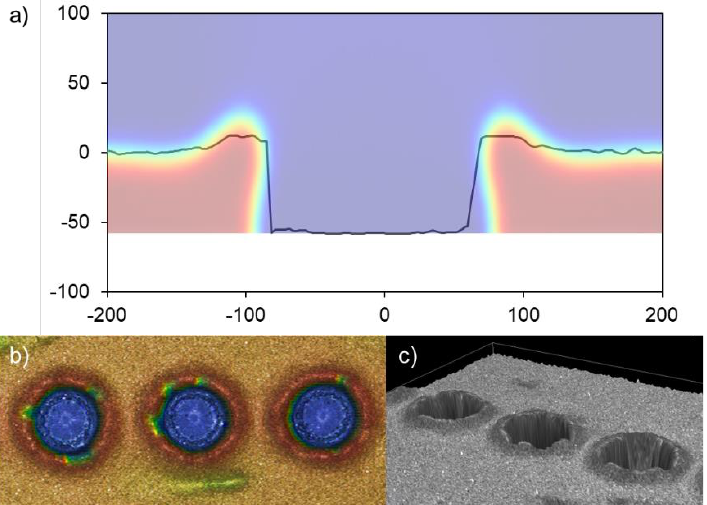
Figure 13. Annular bulge shaping in the donor after the paste burst for the explosive regime. Confocal profile superposed with a FEM-CFD simulation at a long time — without further evolution — ( a ), a confocal top-view image ( b ), and a confocal 3D view ( c ) are displayed, done with PV19B paste.